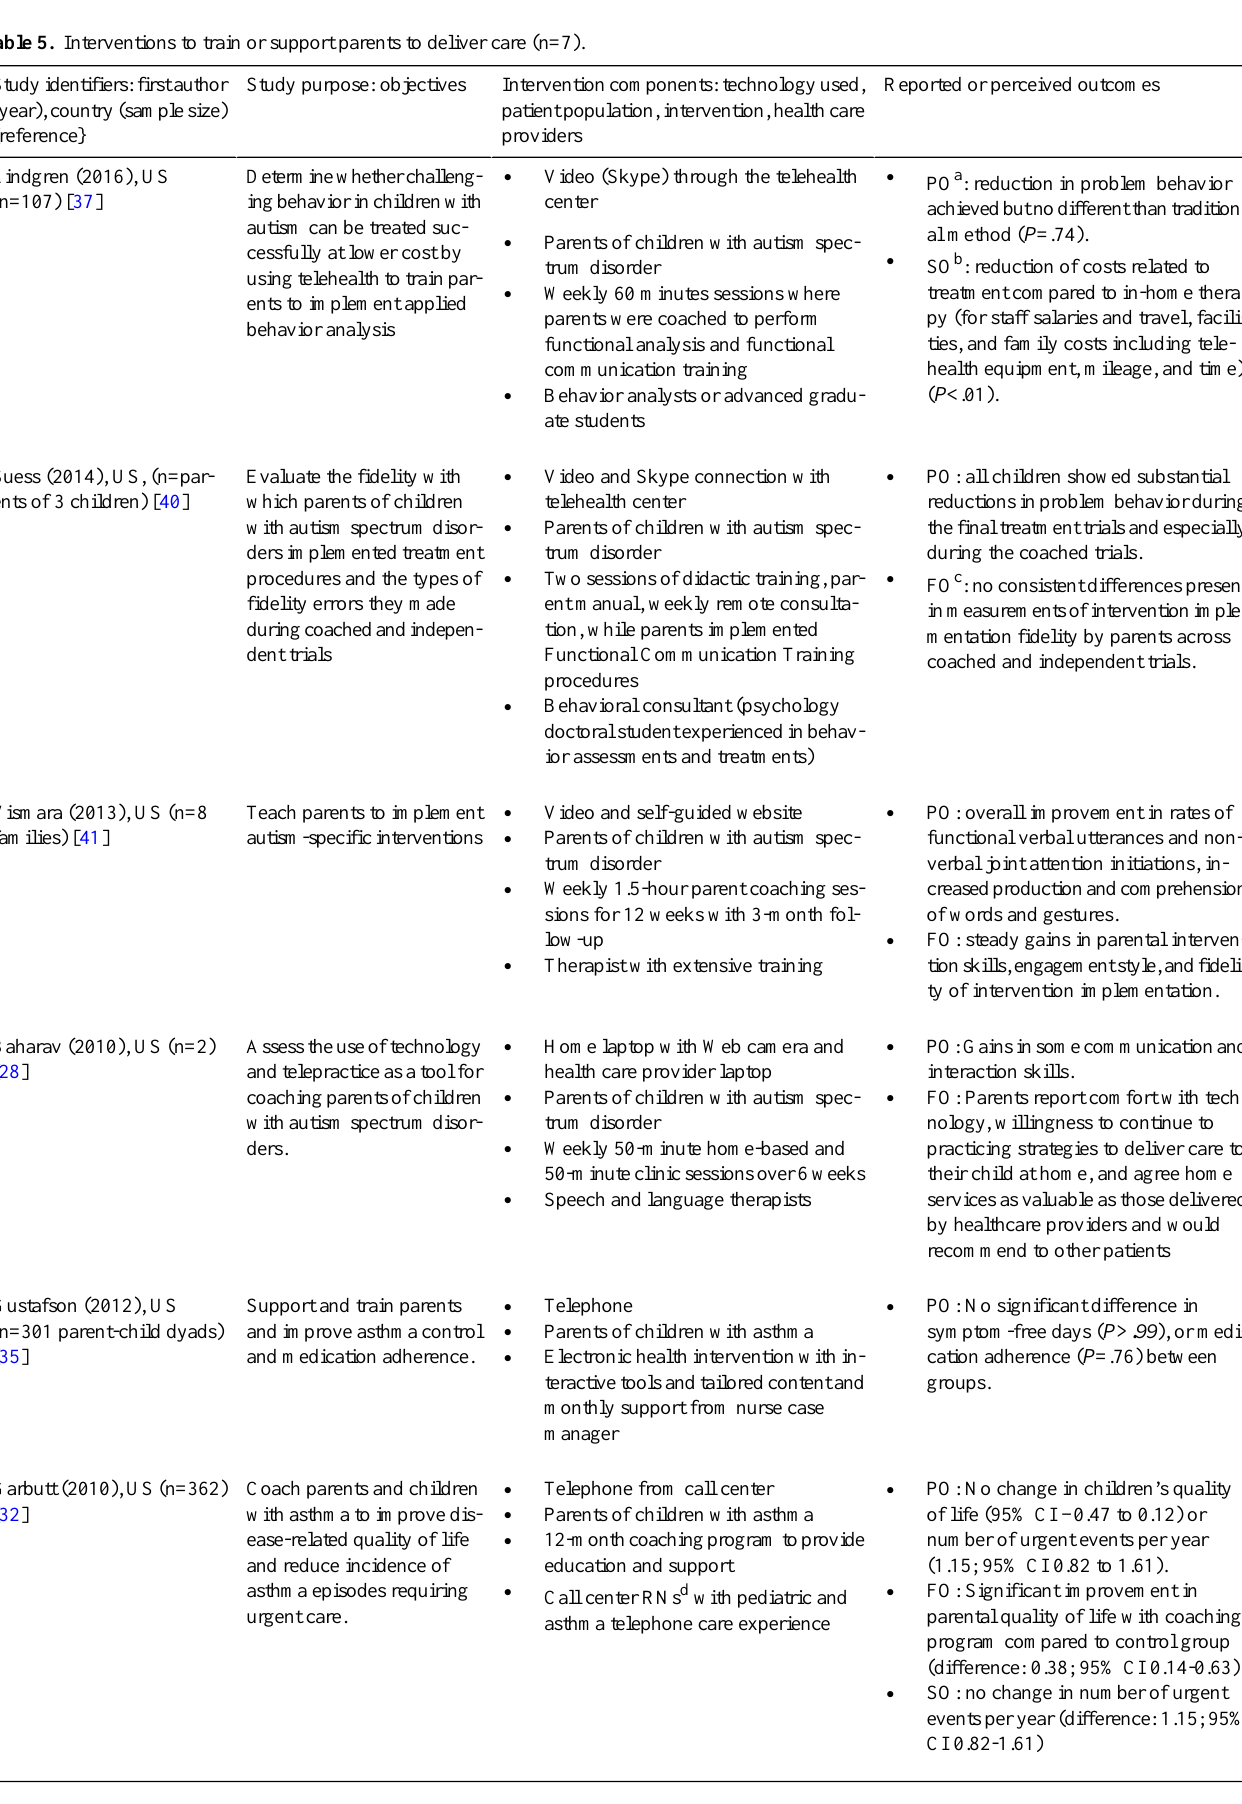
Table 5. Interventions to train or support parents to deliver care (n=7).